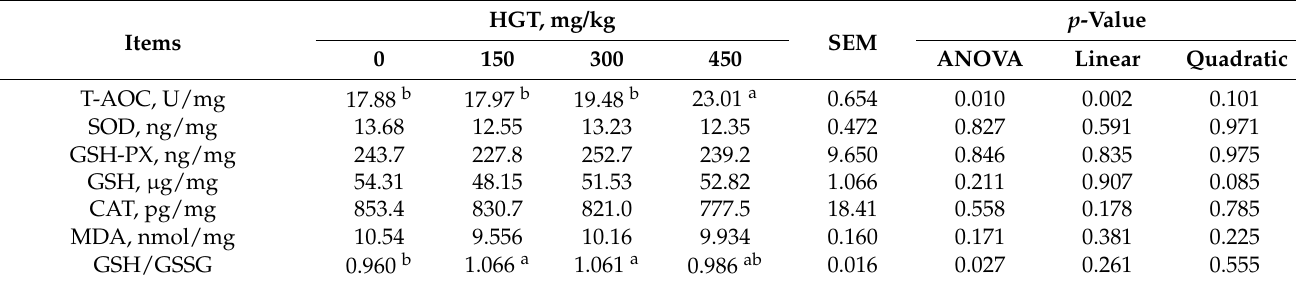
Table 5. The effect of HGT on liver antioxidant function of broilers 1